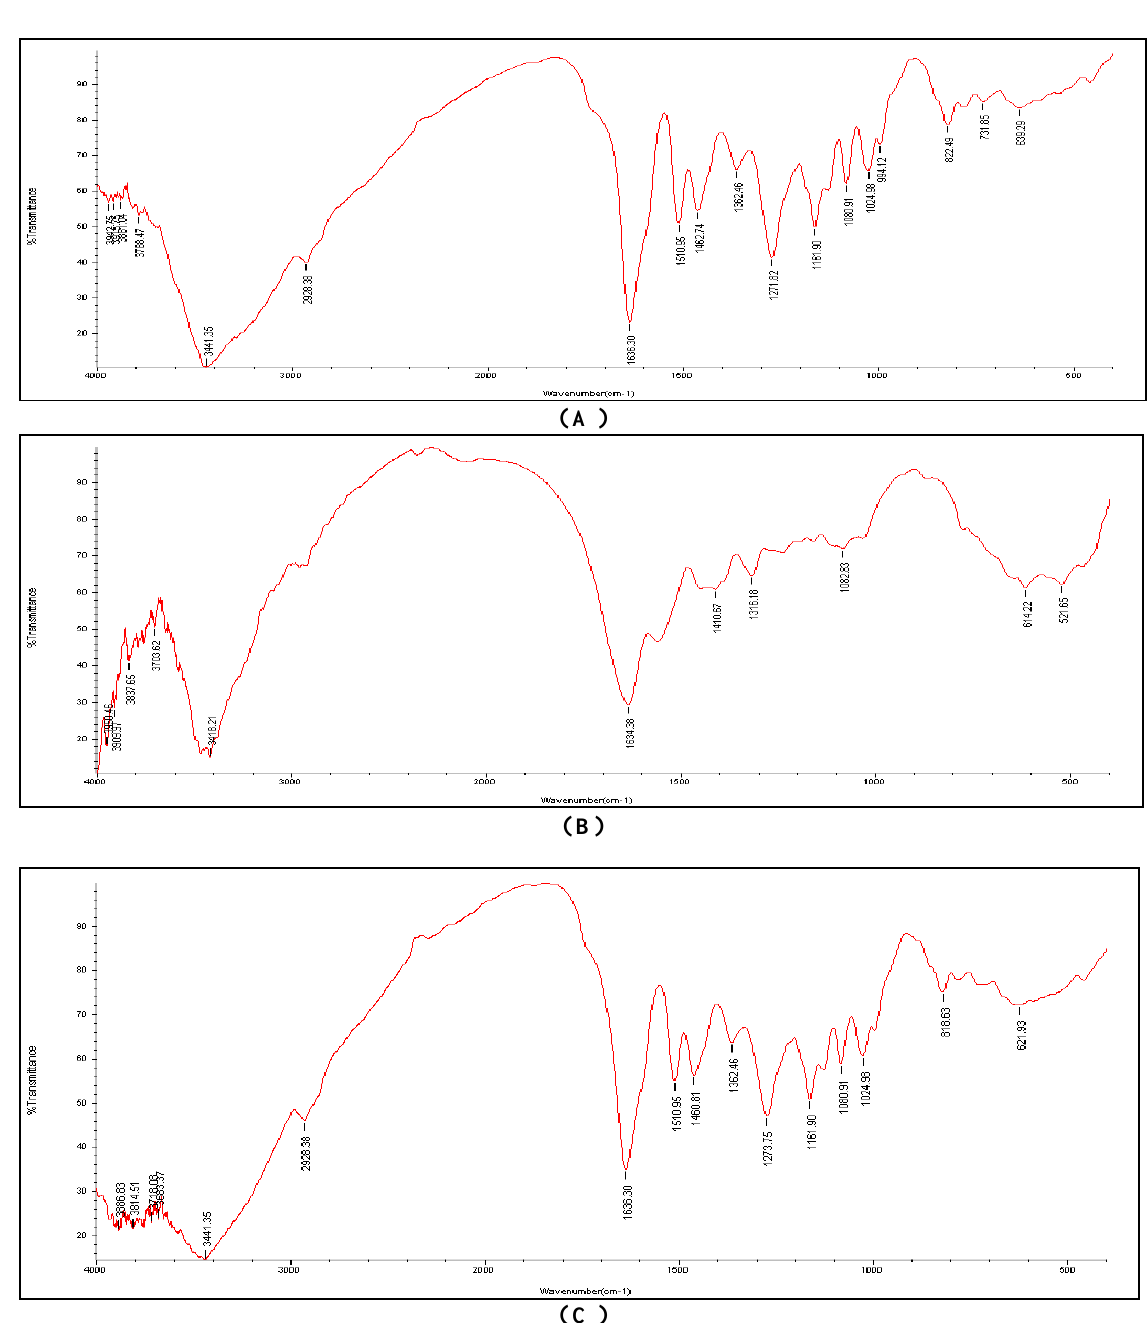
Figure (6) FTIR of SM (A), Gelatin (B), MC9s